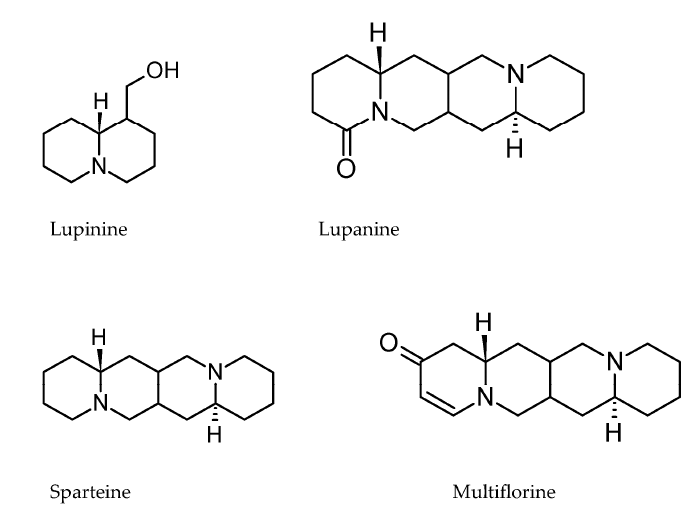
Figure 12. Main alkaloids of lupin species.